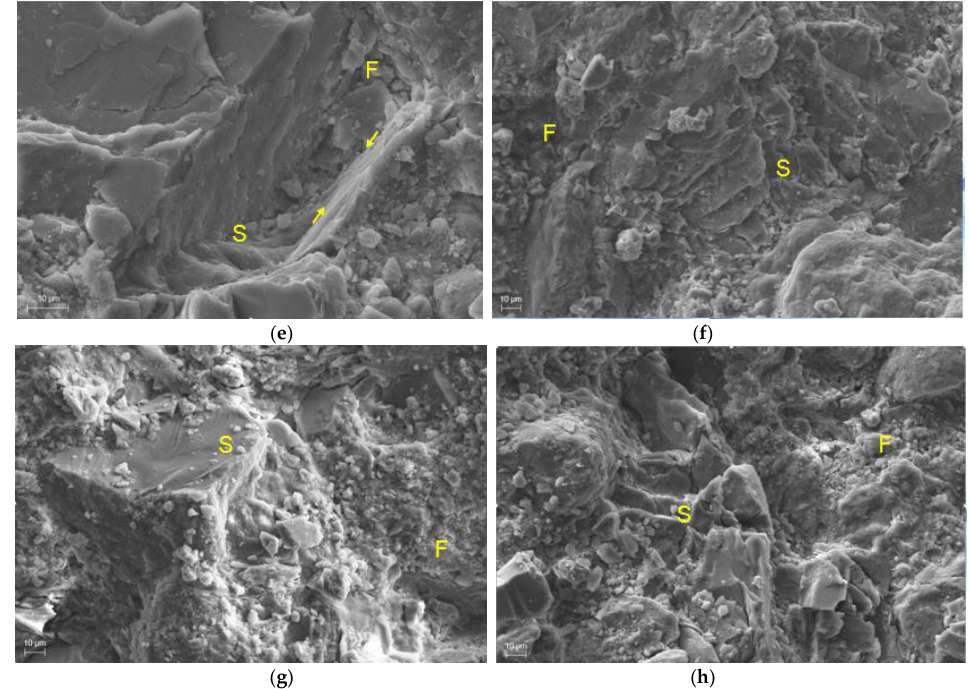
Figure 7. Typical scanning electron microscopy (SEM) images of sandstone fractures with the initial confining pressure 10 and 40 MPa in conventional triaxial compression tests: ( a , b ) TC-D-10; ( c , d ) TC-S-10; ( e , f) TC-D-40; ( g , h ) TC-S-40 (Note: Opposite arrows and inverse arrows represent slip trace and tensile trace respectively; and the letters F, S and T represent fragments, shear crack and tensile crack, respectively).